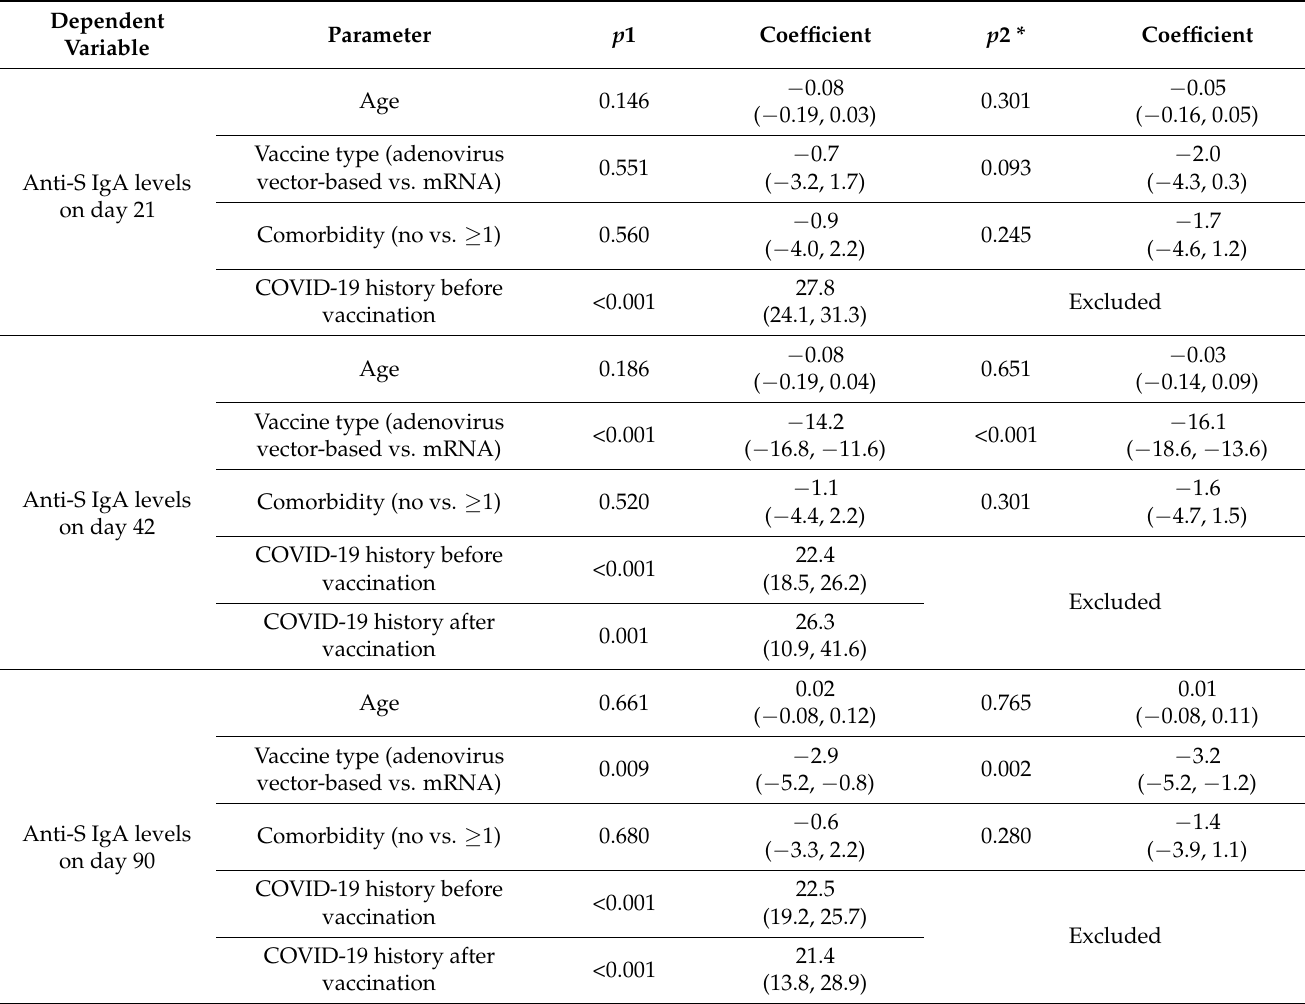
Table 6. Multivariate analyses of anti-SARS-CoV-2 IgA responses after vaccination with adenovirus